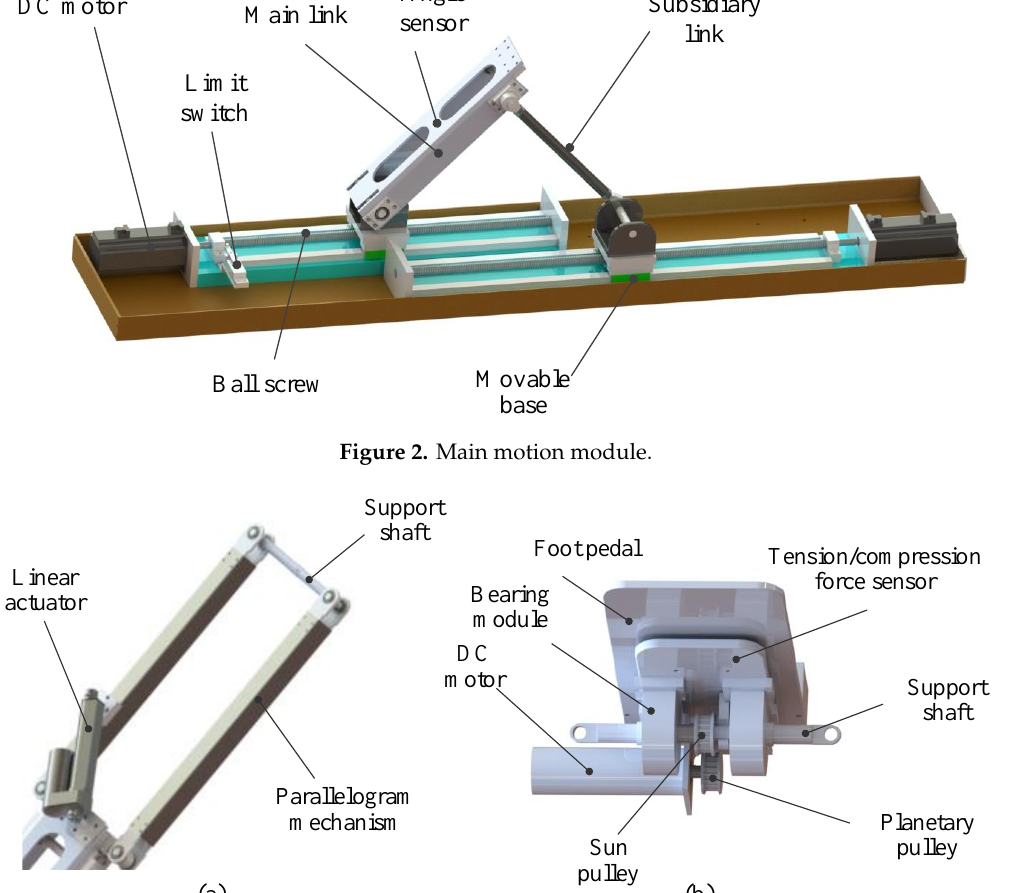
Figure 2. Main motion module.